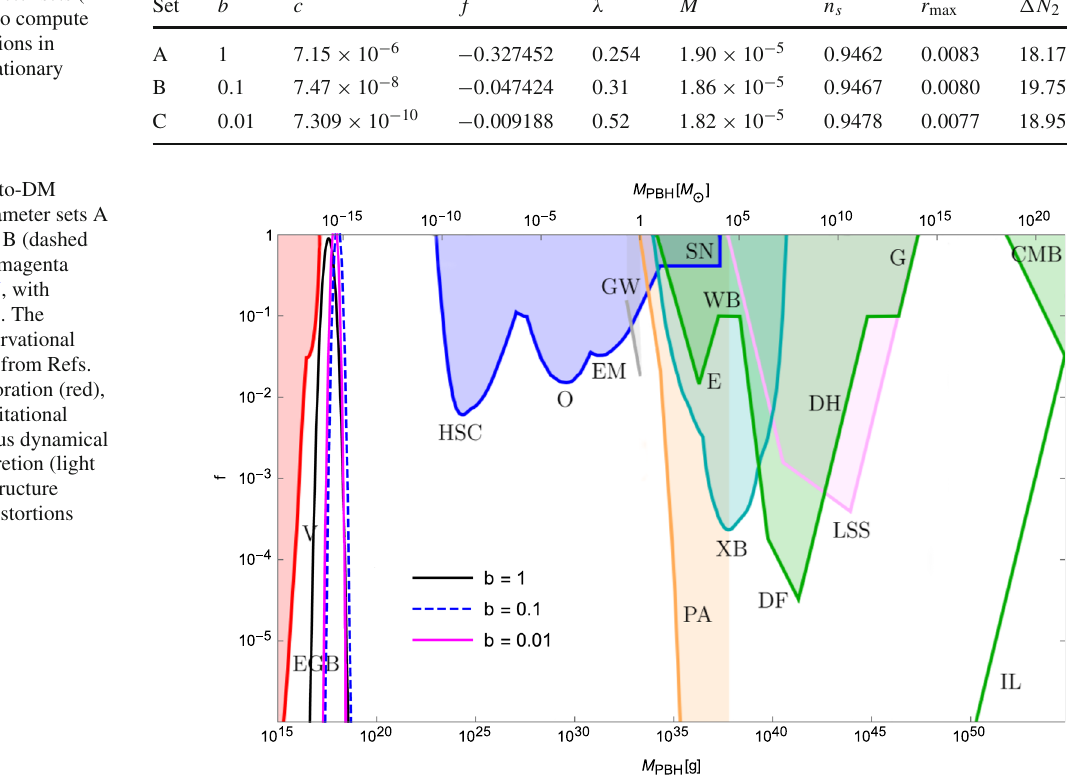
Table 7 The parameter sets (in Planck units) used to compute the PBH mass fractions in Fig. 12 and the inflationary observables